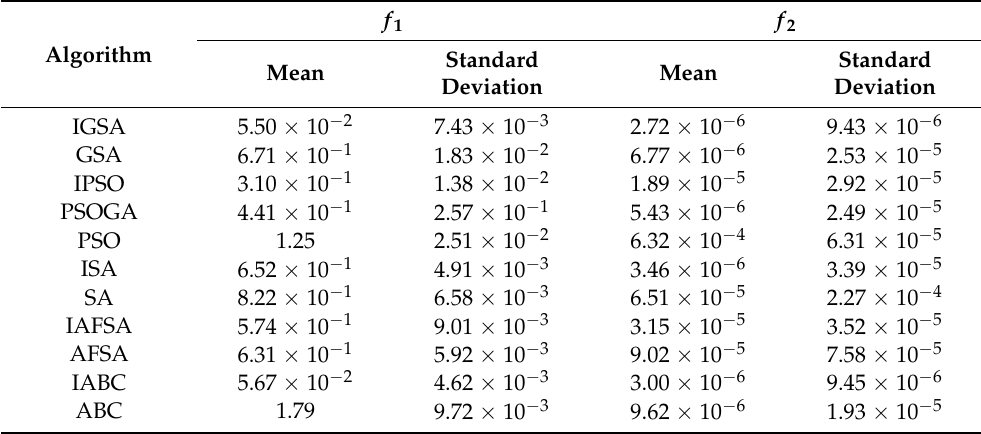
Table 1. The mean and standard deviation values obtained from different algorithms for bench- mark functions.